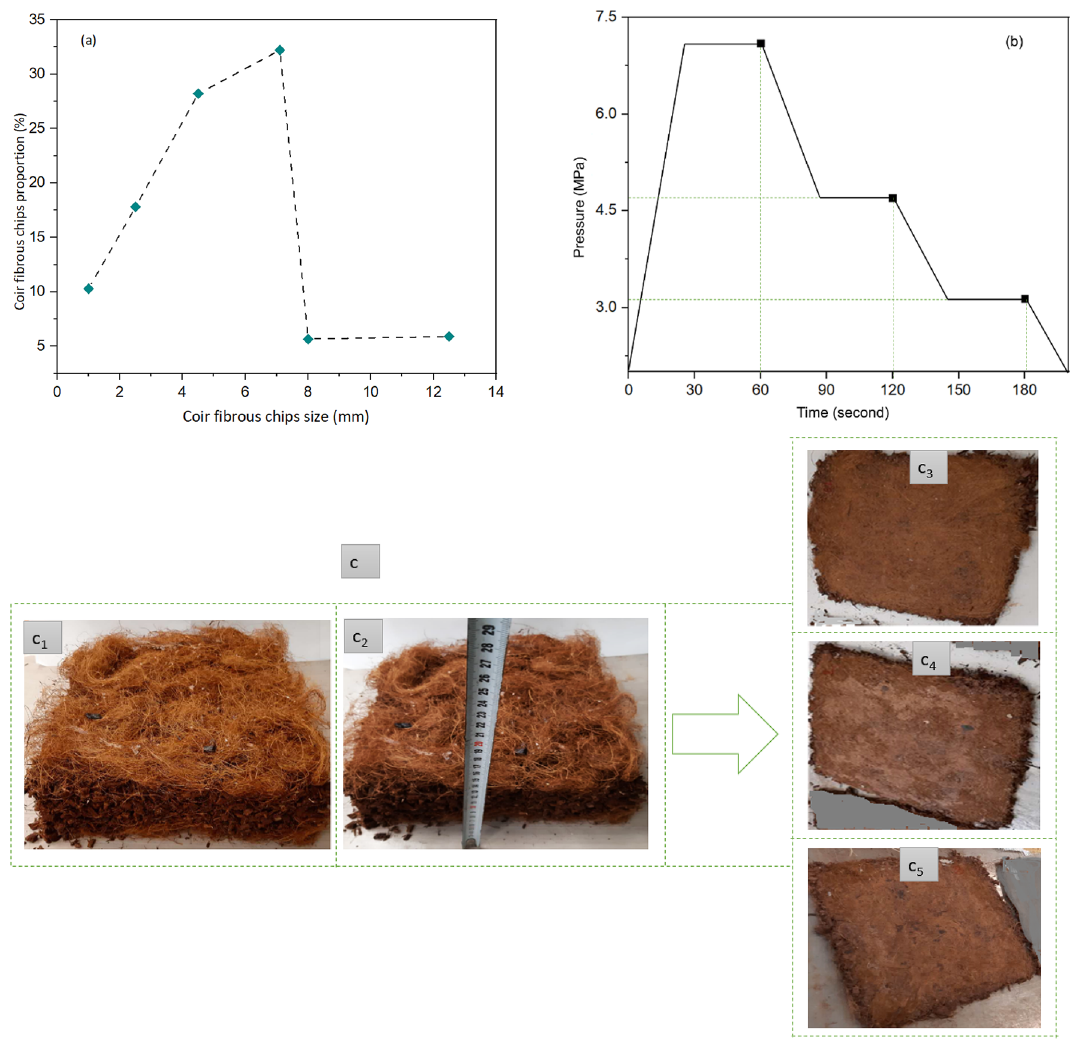
Figure 2. ( a ) Sieve analysis, ( b ) Applied pressure (MPa) against different time intervals for the production of C@BC 1, C@BC 2, and C@BC 3, ( c ) Schematic representation of biocomposites manufacturing process: c 1 and c 2 : before hot pressing, c 3 , c 4 , and c 5 : after hot